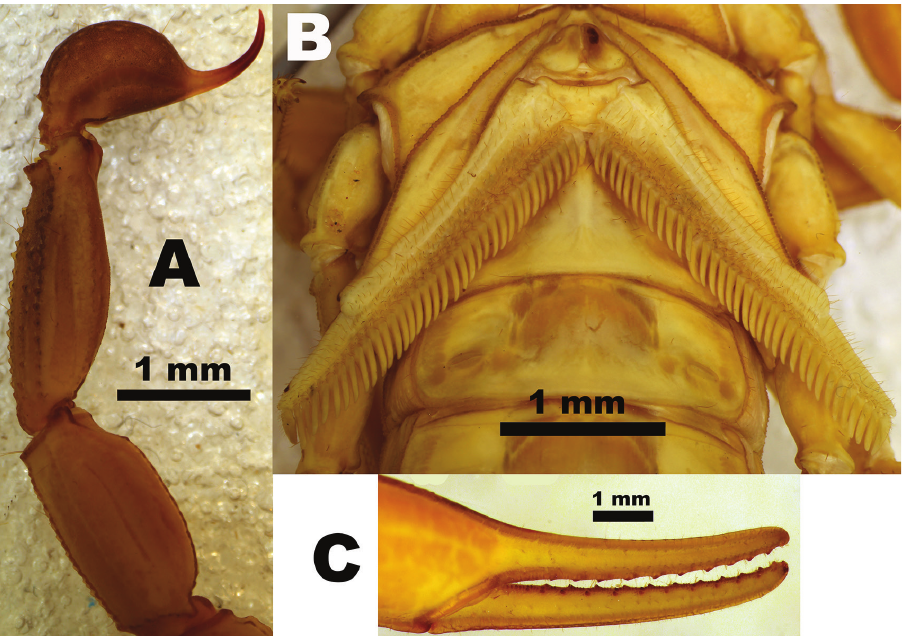
Figure 15. Detailed morphology of the larger syntype of B. nigrovesiculosus (NHMUK) A Lateral view of the telson and two terminal segments of the metasoma B Ventral view of the mesosoma, with pectines clearly vis- ible C External lateral view of the terminal half of the right pedipalp che-la. All photos by Sérgio